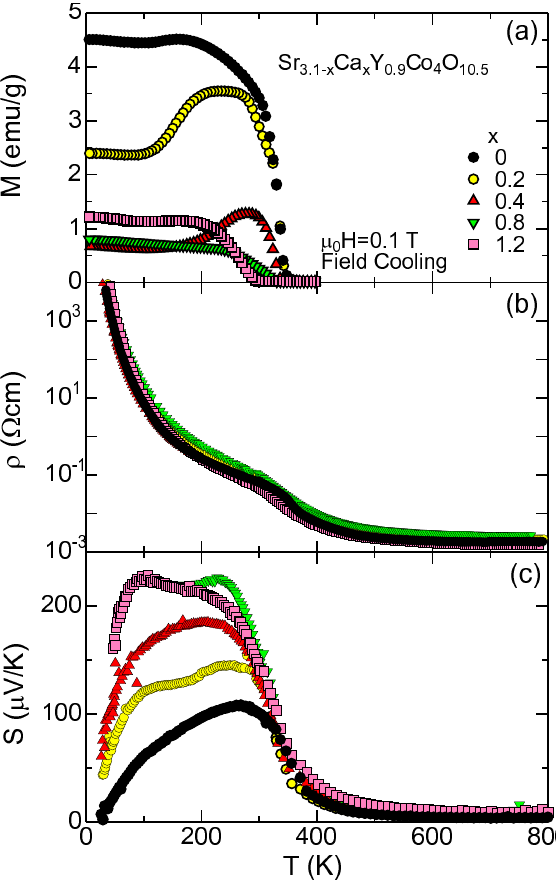
Figure 3 . The physical properties of the Ca-substituted SYCO. (a) Magnetization M in 0.1 T, (b) resistivity ρ and (c) thermopower S